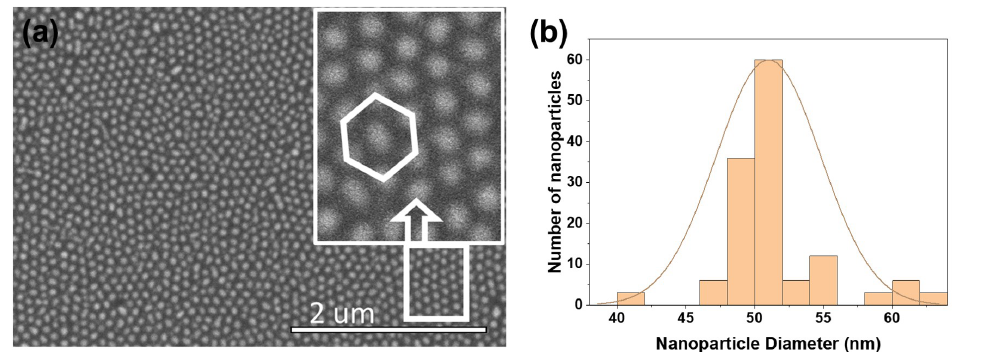
Figure 5. ( a ) SEM image of the AAO membrane surface following dewetting using 8 nm of gold. The inset is an enlarged view of the array showing hexagonal close-packed ordering. ( b ) Distribution of gold nanoparticle size taken over a 1.0 µ m 2